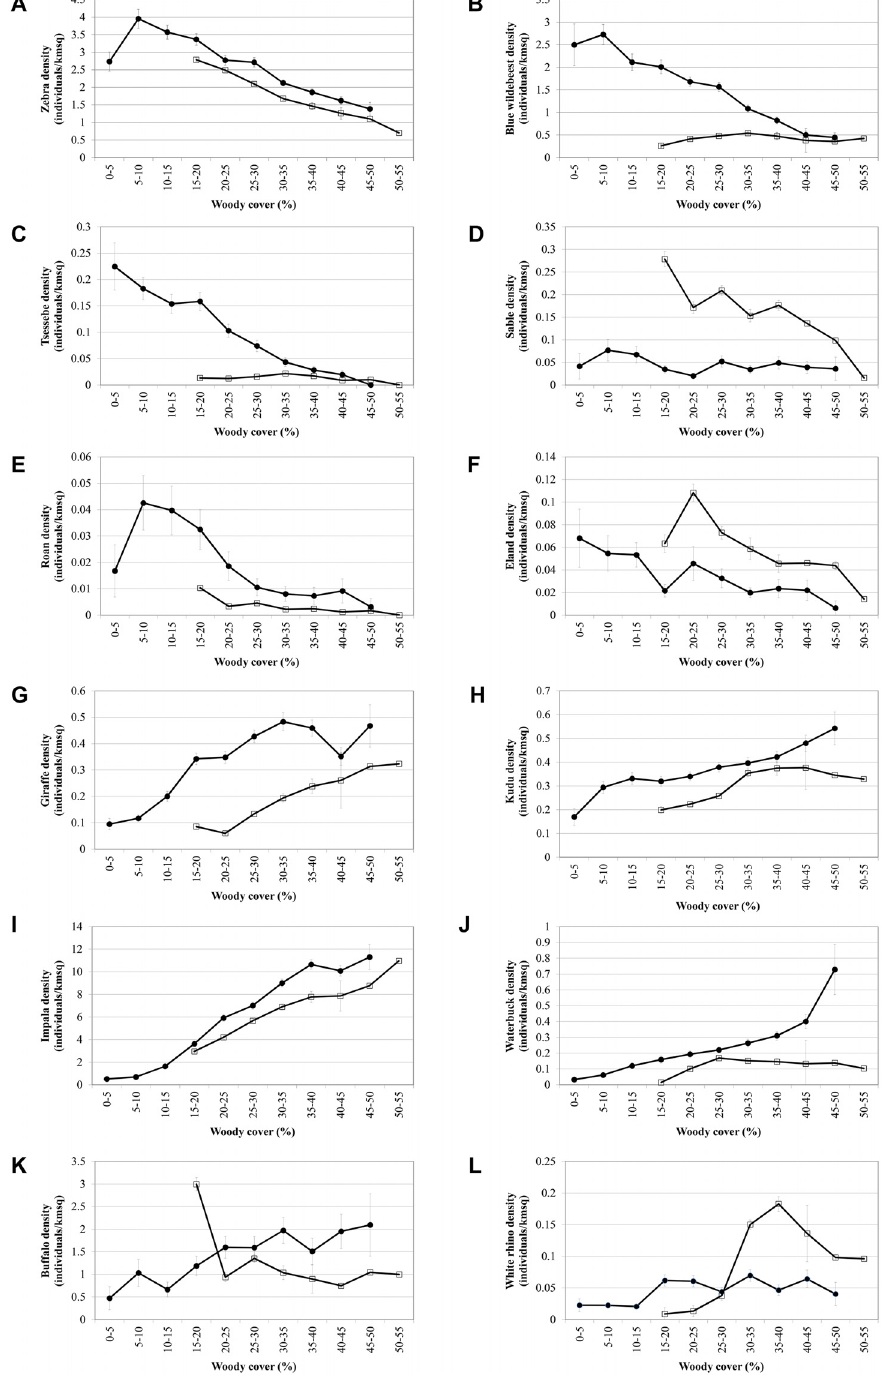
Fig 2. Average herbivore density (individuals.km -2 ) observed along a woody cover gradient. (basalts: solid circles; granites: open squares) (standard error bars included). Meso-grazers including (a) zebra, (b) blue wildebeest, (c) tsessebe, (d) sable and (e) roan, as well as the mixed feeding (f) eland decrease along a gradient of increasing woody cover. Browsers including (g) giraffe and (h) kudu, as well as the mixed feeding (i) impala increase along the woody cover gradient. Some species did not show a consistent trend across the geologies, including (j) waterbuck, (k) buffalo and (l) white rhino (refer to Table 2 for the slope coefficients).